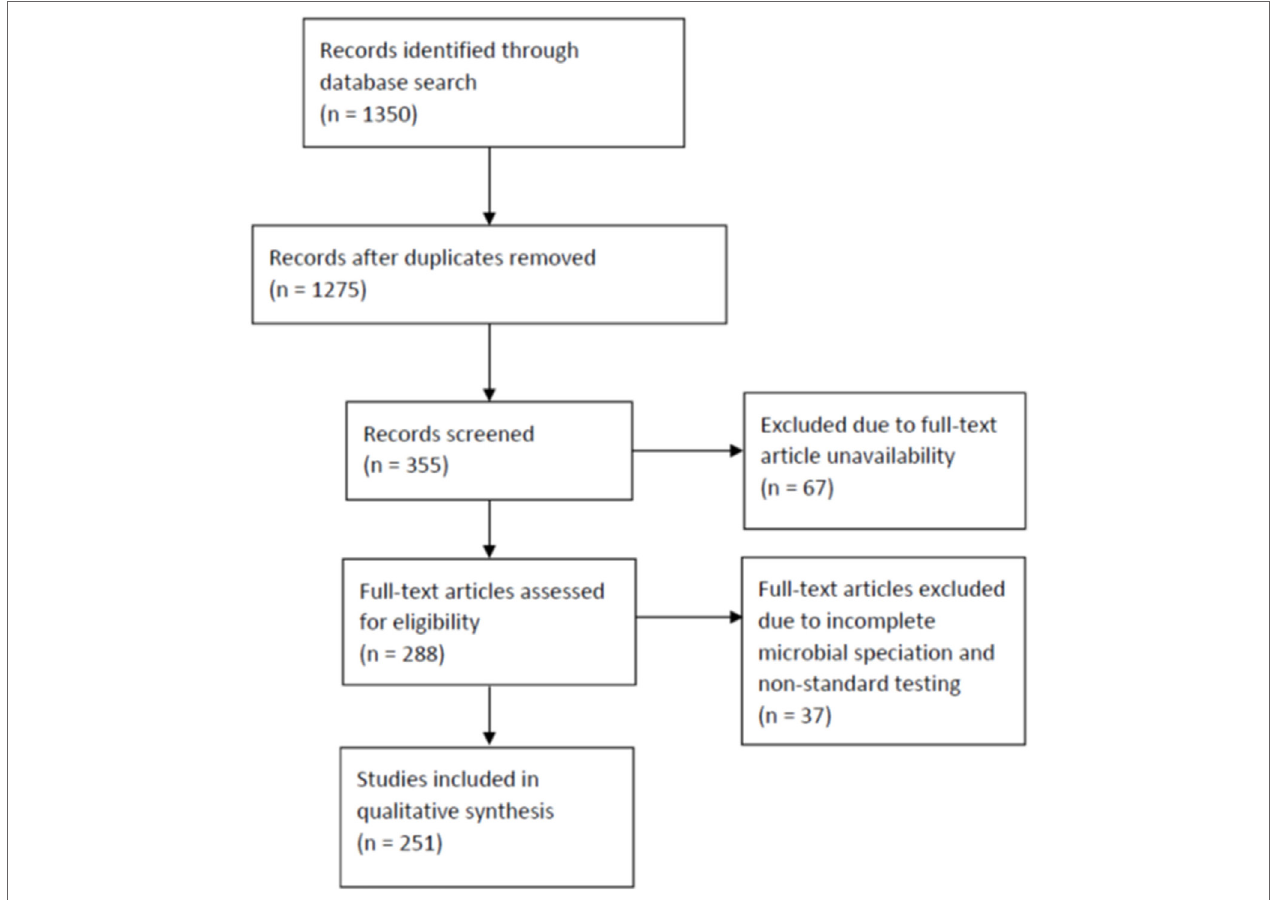
FiGURe 1 | Preferred Reporting Items for Systematic Reviews and Meta-Analyses flow diagram for searched